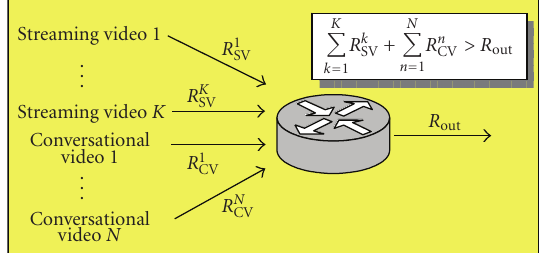
Figure 1: A network node with K incoming streaming videos and N conversational videos sharing the same outgoing